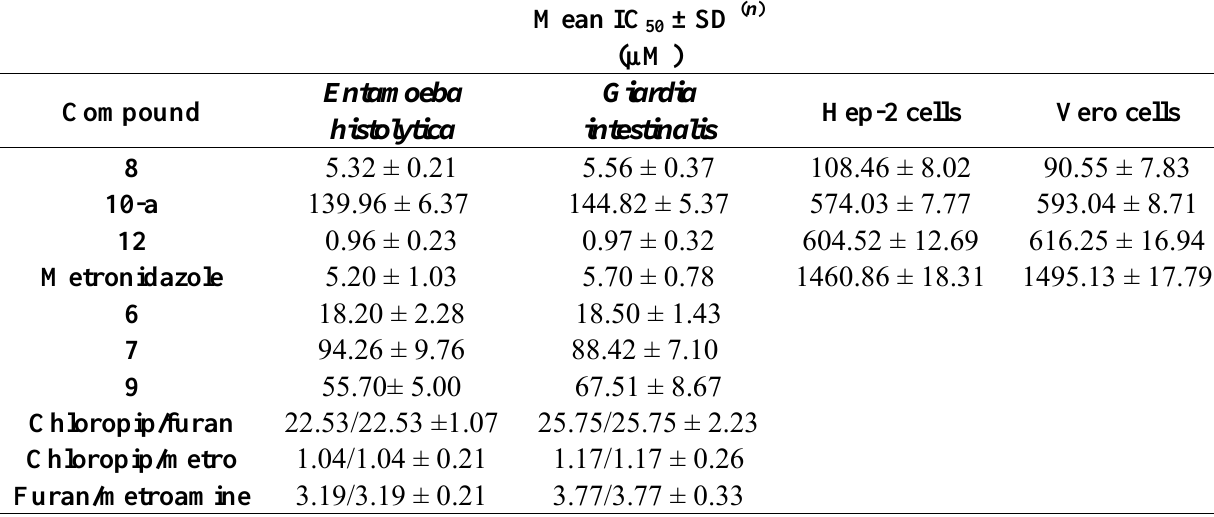
Table 1. In vitro antiamoebic and antigiardial activities of compounds 8 , 10-a , 12 , their precursors, and the standard drug, metronidazole, and the cytotoxic activity of 8, 10-a , 12, and